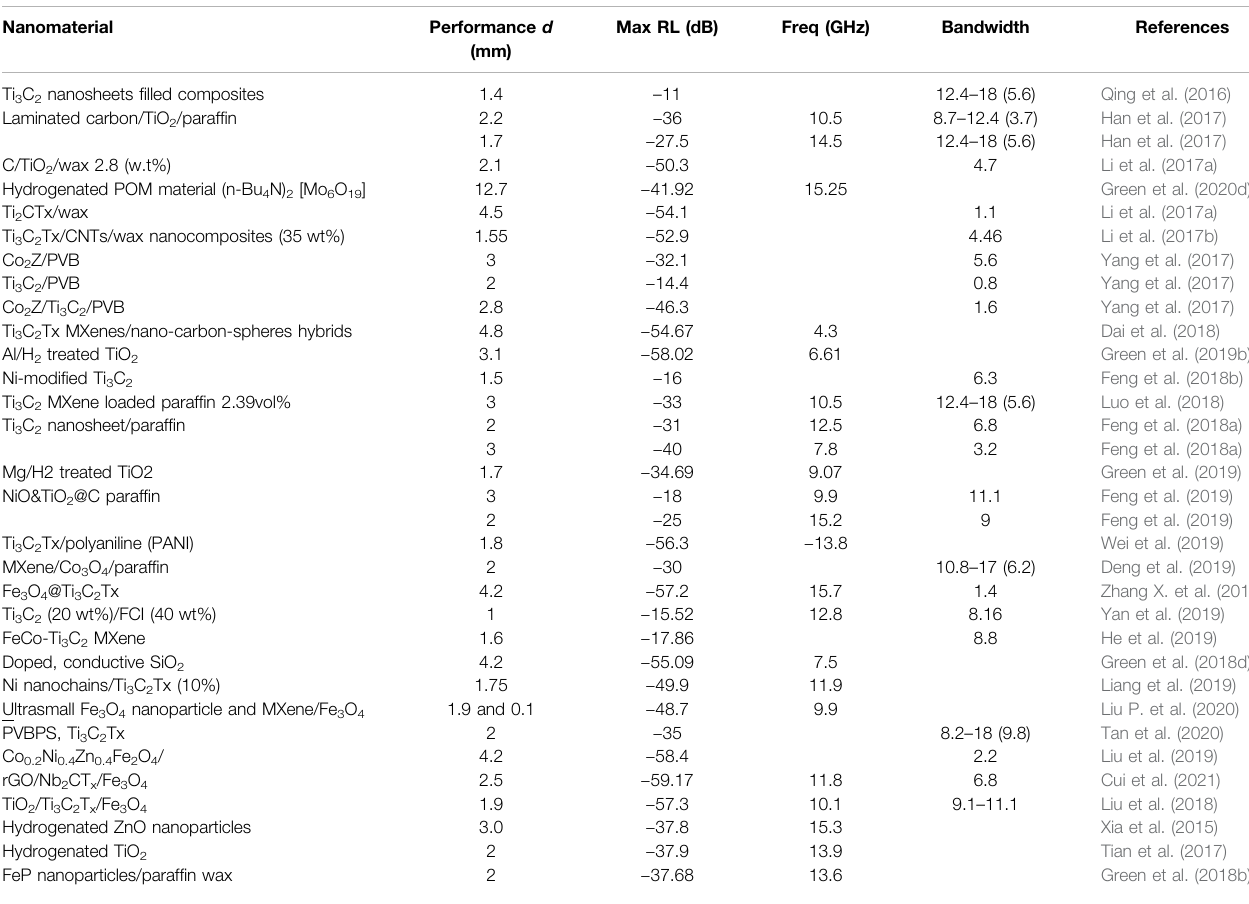
TABLE 3 | MXene-based composites for microwave